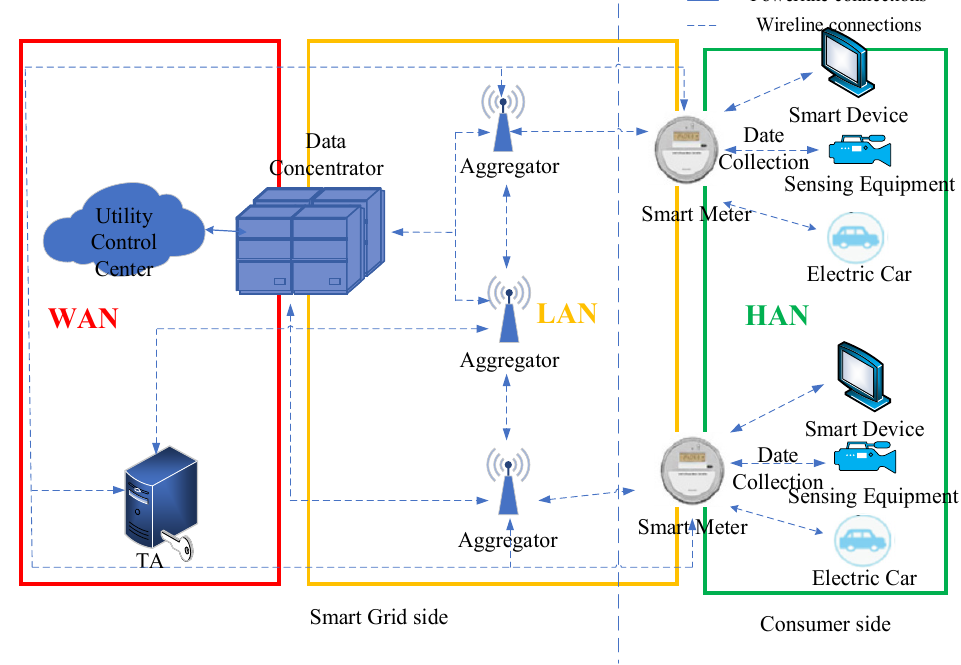
Figure 1. Architecture of Communication Networks in SG.